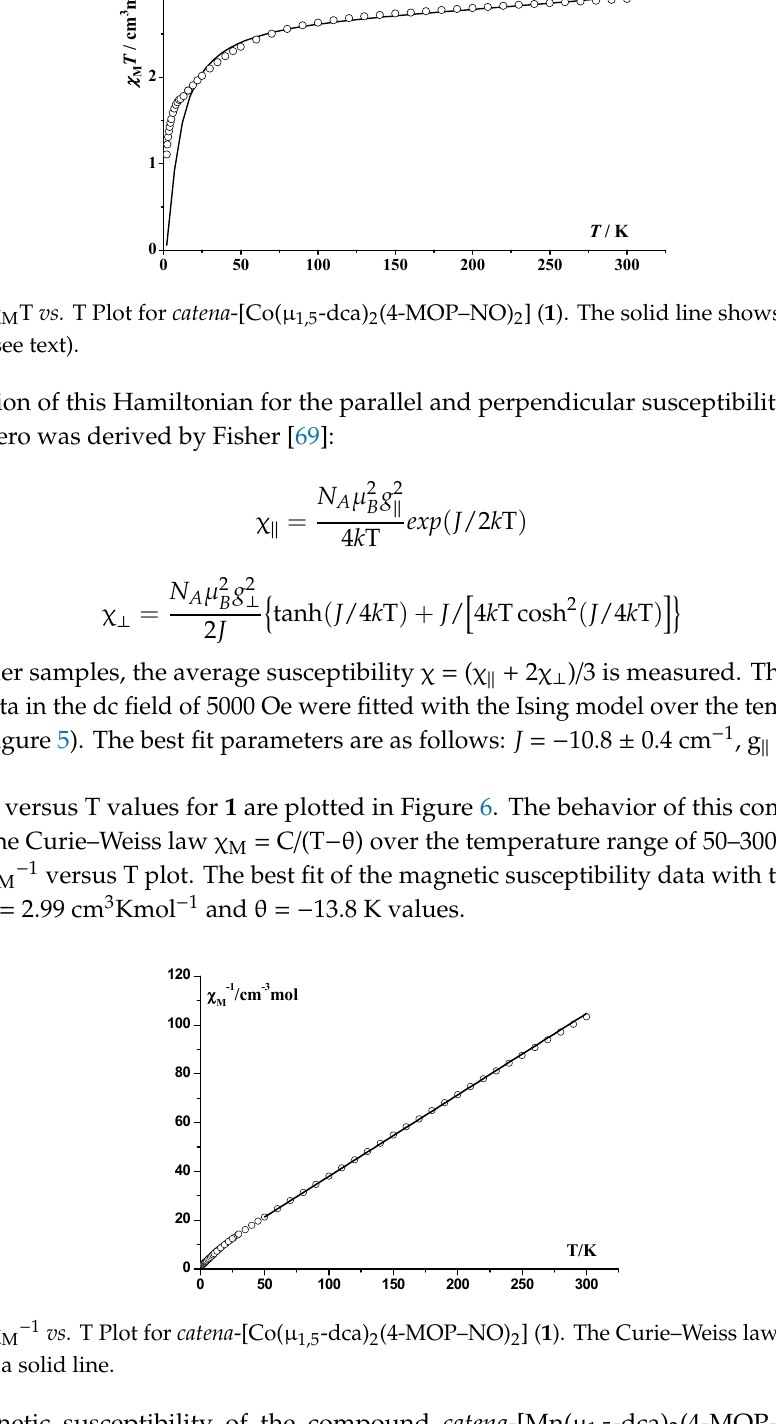
Figure 6. χ M − 1 vs. T Plot for catena -[Co( µ 1,5 -dca) 2 (4-MOP–NO) 2 ] ( 1 ). The Curie–Weiss law; the best fit is given as a solid line.